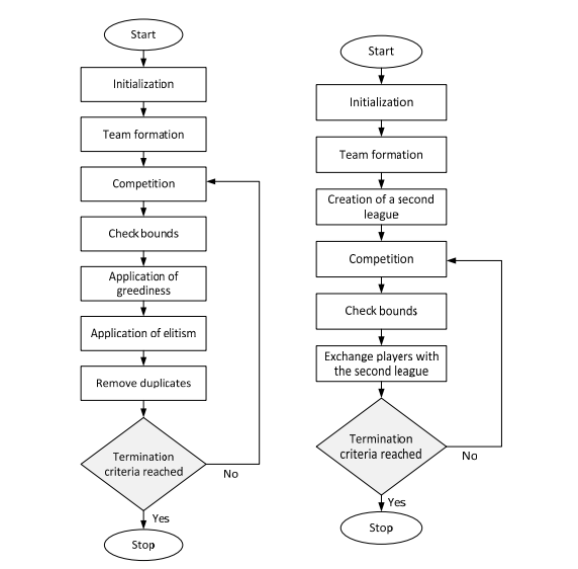
Figure 3. PSO (left) vs LEACH